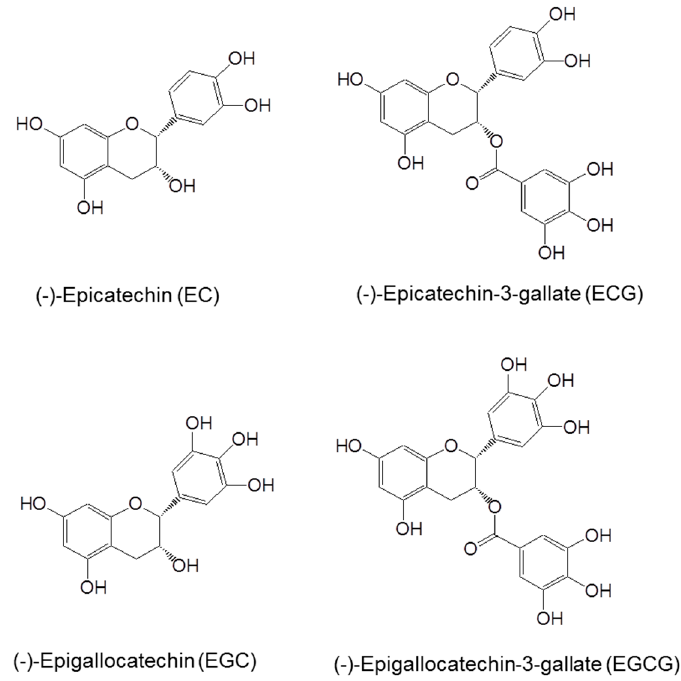
Figure 1. Structures of ( − )-epigallocatechin-3-gallate (EGCG), ( − )-epicatechin-3-gallate (ECG), ( − )-epigallocatechin (EGC) and ( − )-epicatechin (EC).